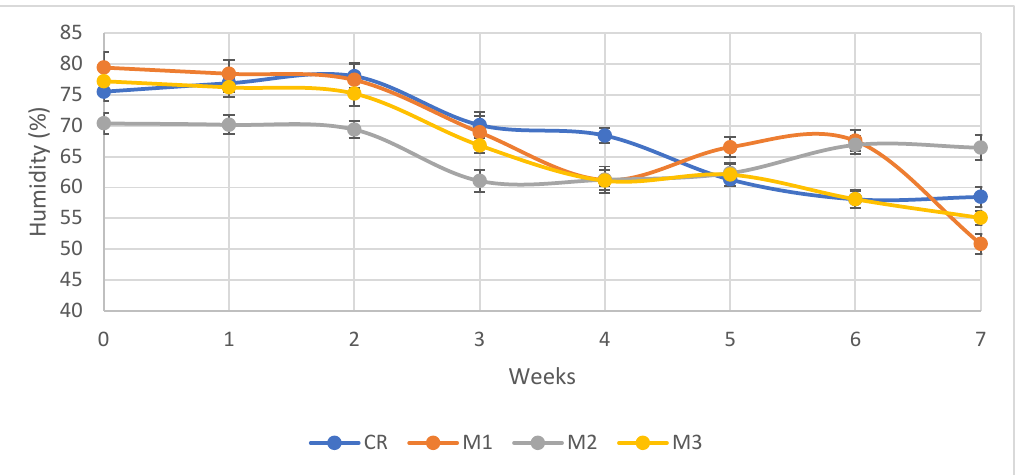
Figure 8. Humidity behavior in mixtures (CR, M1, M2 and M3) during vermicomposting process.